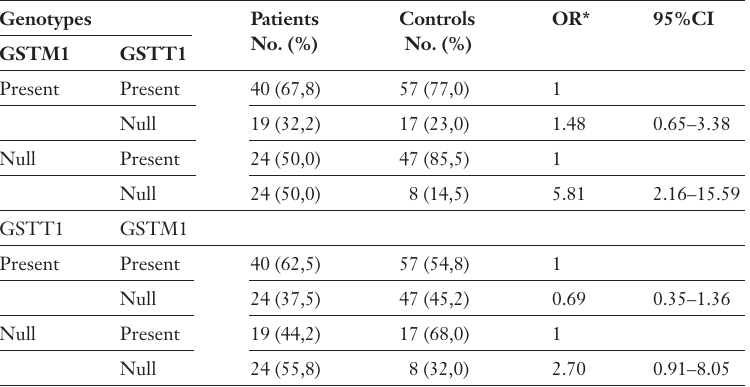
Combined effects of GSTM1 and GSTT1 genotypes in CML